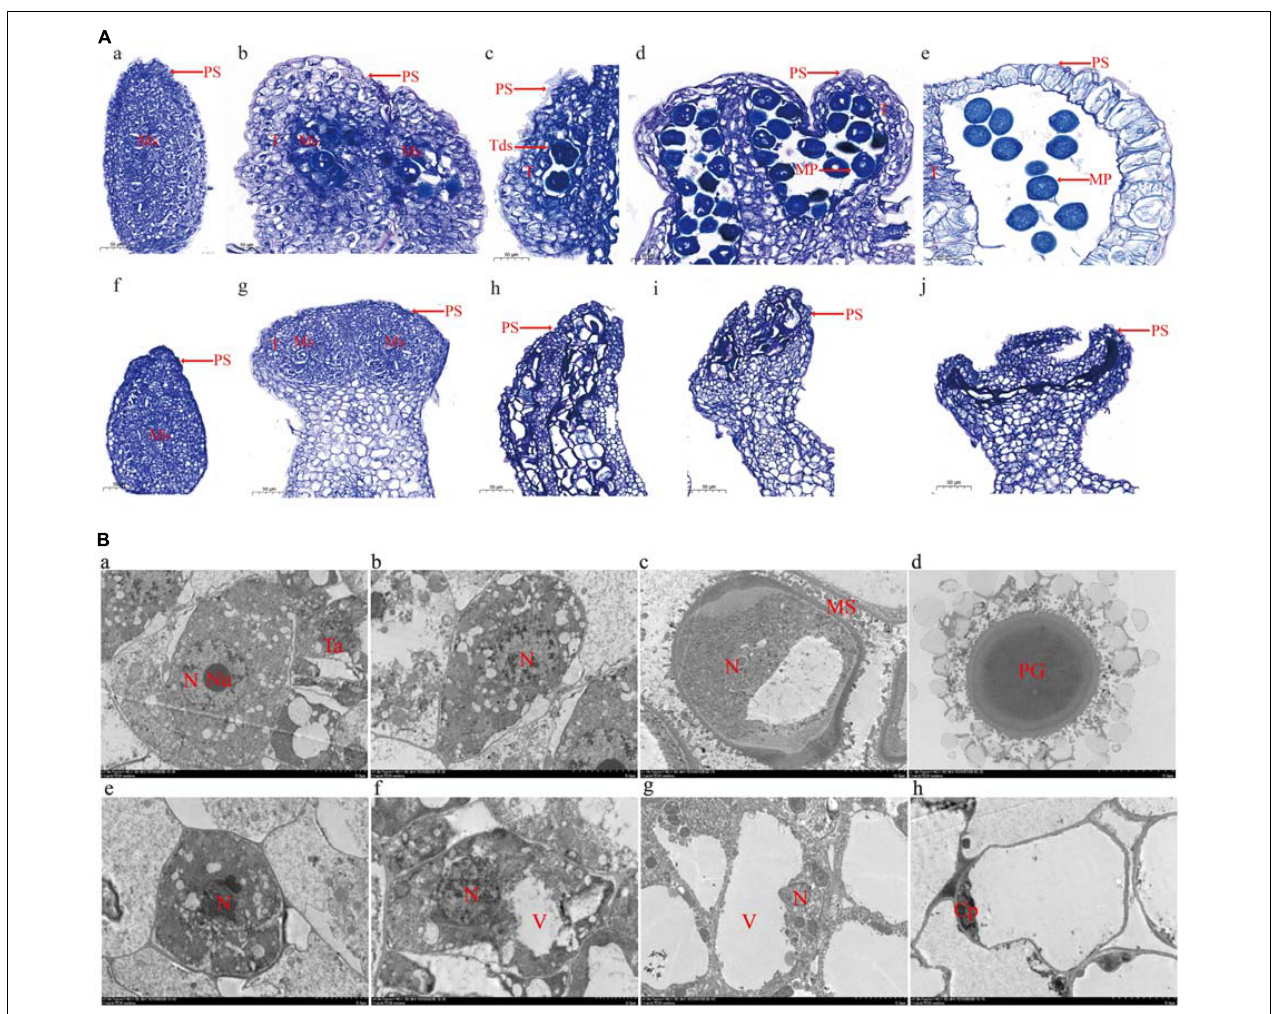
FIGURE 2 | Microscopy analysis of microspore development. (A) Optical microscopy images. Undifferentiated anther (a) , microsporocyte stage (b) , tetrad stage (c) , microspore stage (d) , and mature pollen stage (e) in male-fertile anthers. Undifferentiated anther (f) , microsporocyte stage (g) , microsporocyte abnormal division stage (h) , microsporocyte disaggregated stage (i) , and withered powder chamber (j) in male-sterile anthers. PS , pollen sac; T , tapetum; Tds , tetrads; Ms , microsporocyte; MP , mature pollen. Bar = 50 µ m. (B) Transmission electron microscopy images. Sporogenous cells (a) , microsporocyte (b) , immature pollen (c) , and mature pollen (d) in male-fertile anthers. Sporogenous cells (e) , microsporocyte (f) , abnormal microsporocyte (g) , and hollow and wrinkled pollen (h) in male-sterile anthers. N , nucleus; Nu , nucleolus; Ta , tapetum; MS , microspore; PG , pollen grain; V , vacuole; Cp , cytoplasm. Bar = 50 µ m (each scale = 5 µ